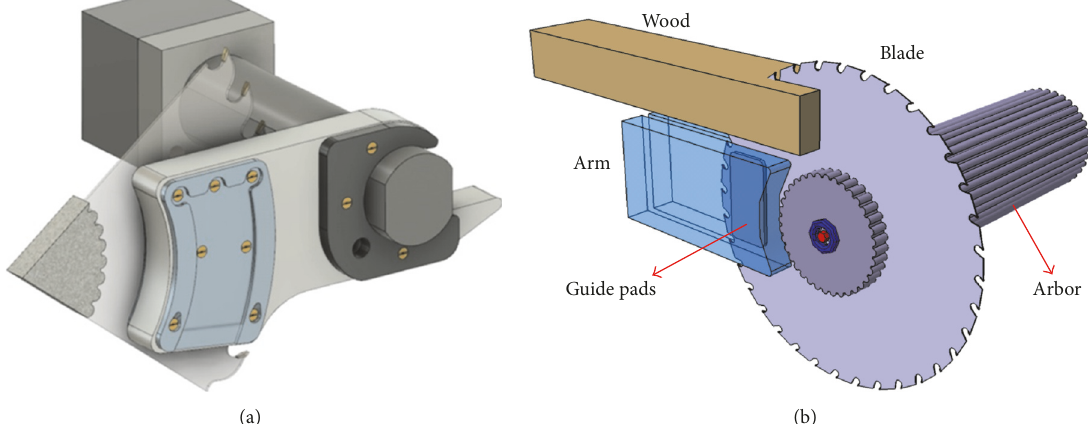
Figure 1: A guided spline saw, practical setup (a), and schematic